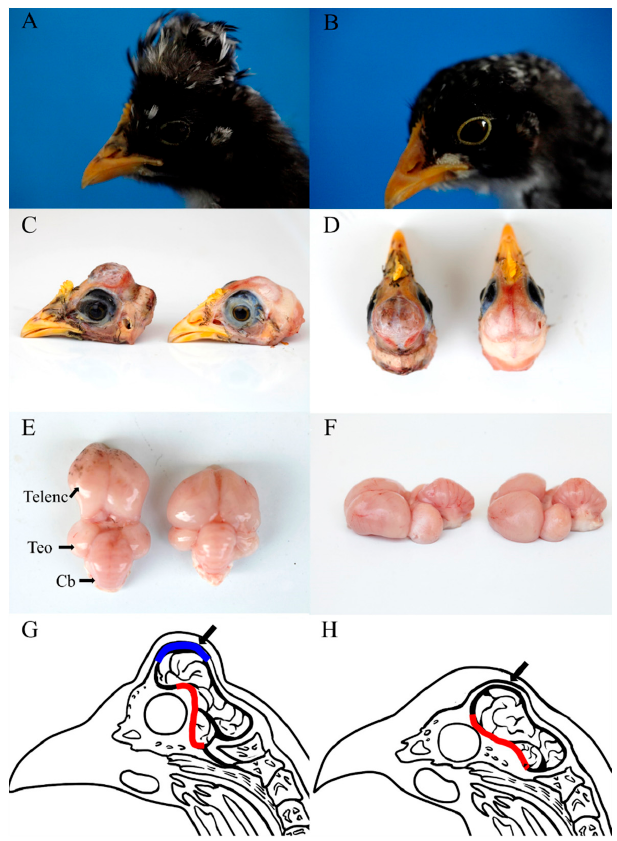
Figure 1. Anatomy and morphology of cerebral hernia type and wild type chickens. ( A , B ) The appearance of chickens with cerebral hernia (cerebral hernia type) ( A ) and without cerebral hernia (wild type) ( B ). ( C , D ) The di ff erences of frontal bone between cerebral hernia type and wild type at P28 are shown in the lateral view ( C ) and dorsal view ( D ), respectively (left, cerebral hernia type; right, wild type). ( E , F ) The external morphology of brain in cerebral hernia type and wild type chickens at P28 from the dorsal ( E ) and lateral view ( F ), respectively (left, cerebral hernia type; right, wild type). ( G ) The diagram revealed abnormal development of the sphenoid bone and membranous frontal bone in the cerebral hernia type chickens (misplaced sphenoid bone is denoted in red, and the membranous frontal bone is denoted in blue region and with a black arrow). ( H ) The diagram showed the morphology of the sphenoid bone and frontal bone in wild type chickens (sphenoid bone is denoted in red, and frontal bone is indicated by a black arrow). Cb, cerebellum; Telenc, telencephalon; TeO, optic